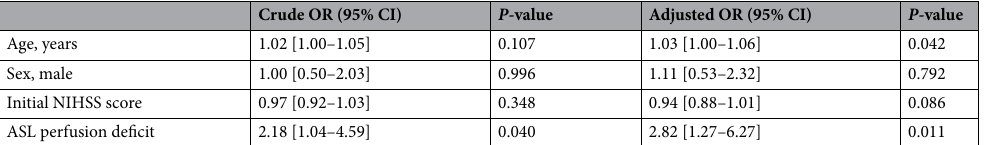
Table 2. Multivariable logistic regression analysis of possible predictors for early recurrent ischemic lesion. NIHSS National Institutes of Health Stroke Scale, ASL arterial spin labeling.